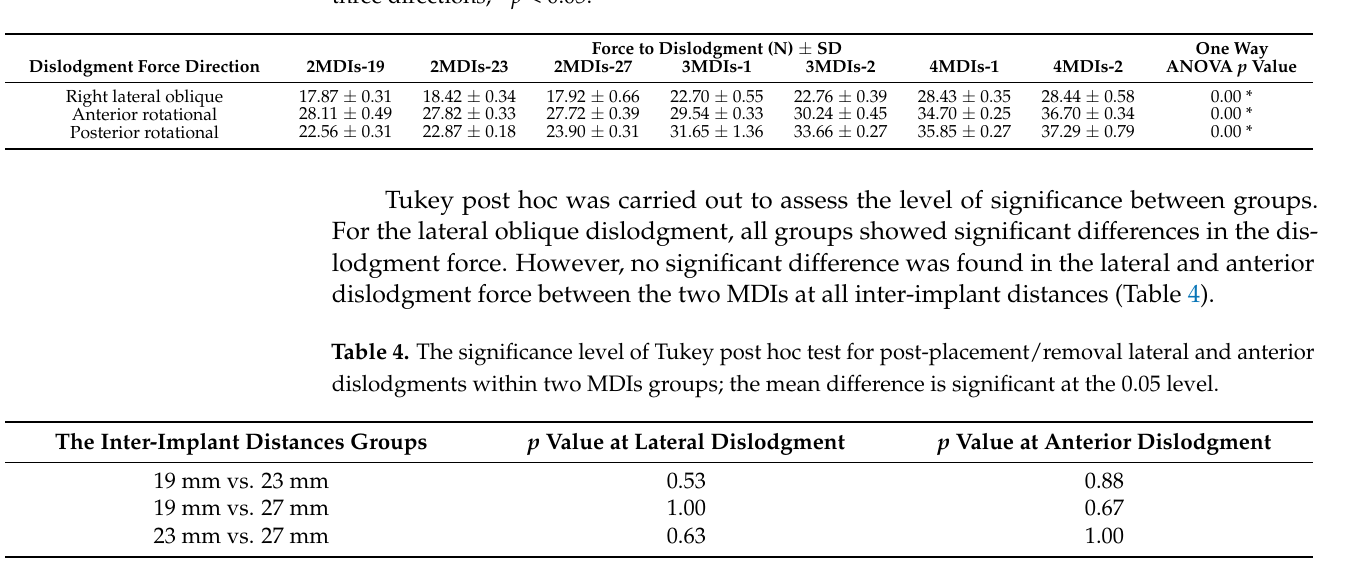
Table 3. The post-placement/removal mean ± standard deviation of force to dislodgement in three directions, * p < 0.05.